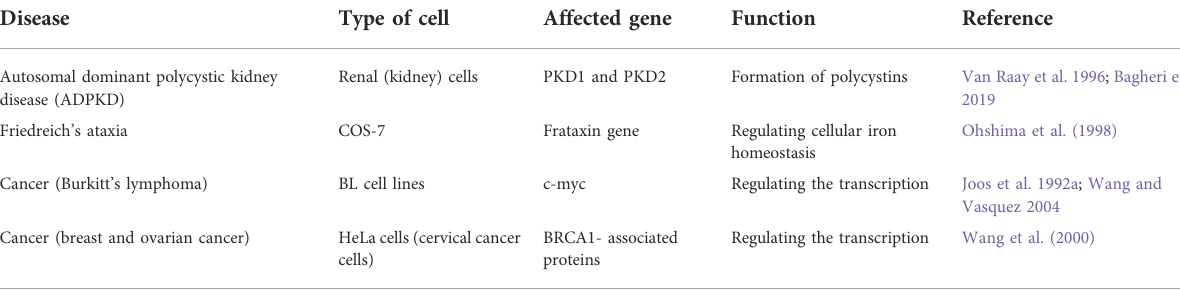
TABLE 2 Human genetic diseases associated with DNA